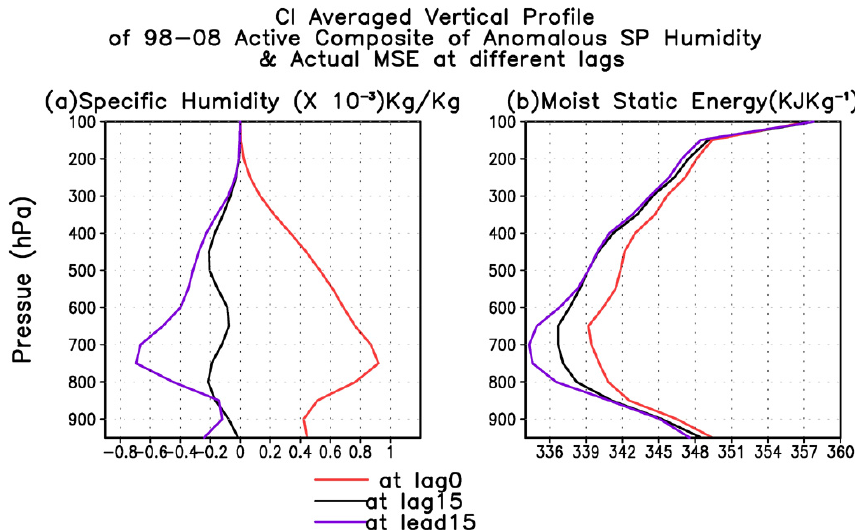
Fig. 17. Central India averaged vertical profile of (a) specific humidity (Kgkg − 1 ) and (b) moist static energy (KJkg − 1 ) for lag − 15, lag 0 and lead 15 based on MERRA.